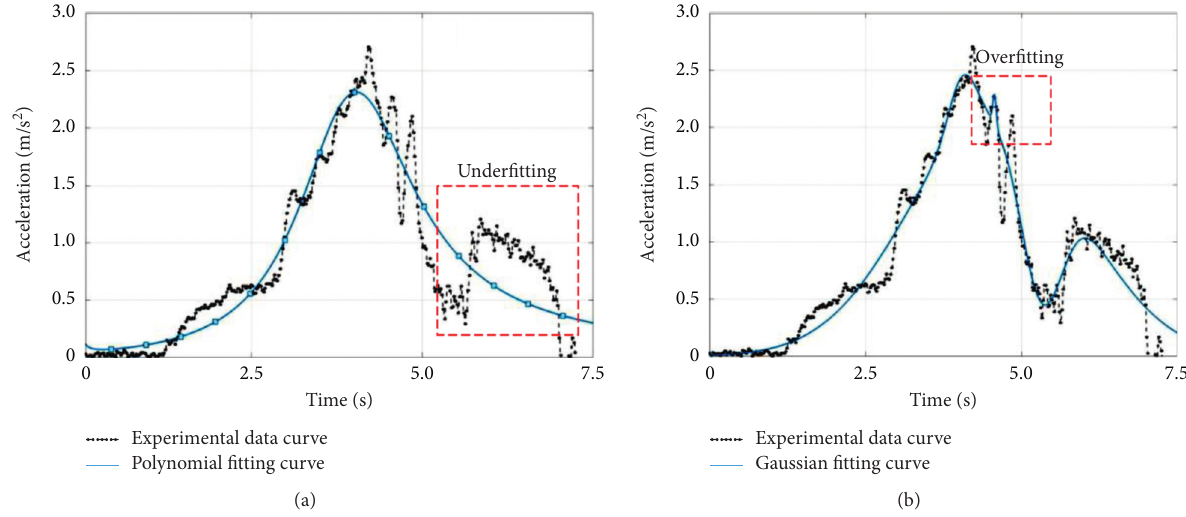
Figure 4: Acceleration fitting based on different fitting methods. (a) Polynomial fitting. (b) Gaussian fitting.